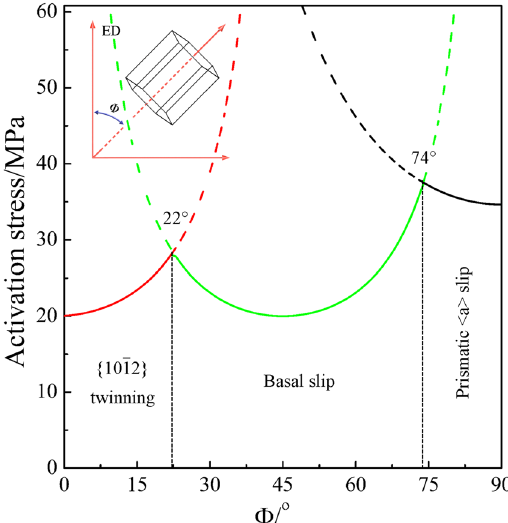
Figure 4. Activation stresses for the dominant deformation modes under tension along the ED as a function of the tilting angle of basal poles ( Φ ) with respect to the ED.